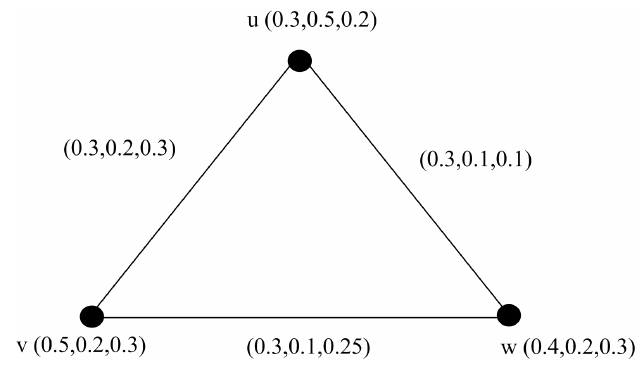
Figure 1. A picture fuzzy graph.